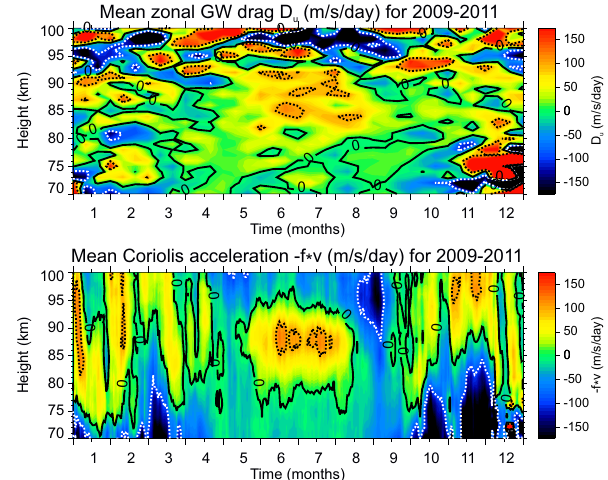
Figure 1. Height–time cross sections of the 3-year mean zonal GW drag D u and negative Coriolis acceleration − f · v from the SMF radar for 2009 through 2011. Zero contour lines are indicated by black solid lines. Contours of negative and positive values are shown with intervals of 100ms − 1 day − 1 with dotted white and black lines, respectively. The GW drag values are averages over 20 days, shifted by 10 days. The Coriolis acceleration is calculated as averages over 7 days, shifted by 1